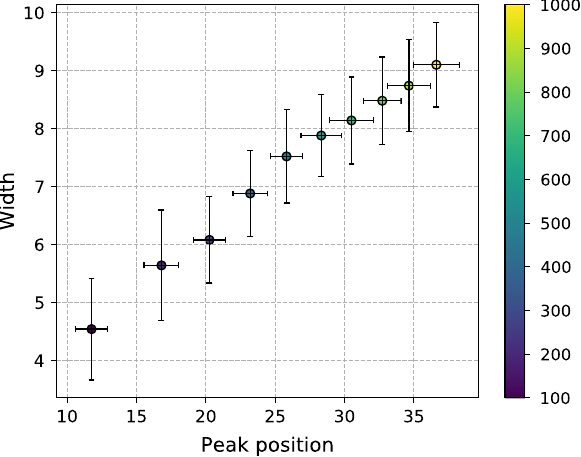
Fig. 2 A plot of width (full width at half maximum) vs peak position for a variety of sizes of sprinkled causal sets. The color indicates the number N of elements in the causal